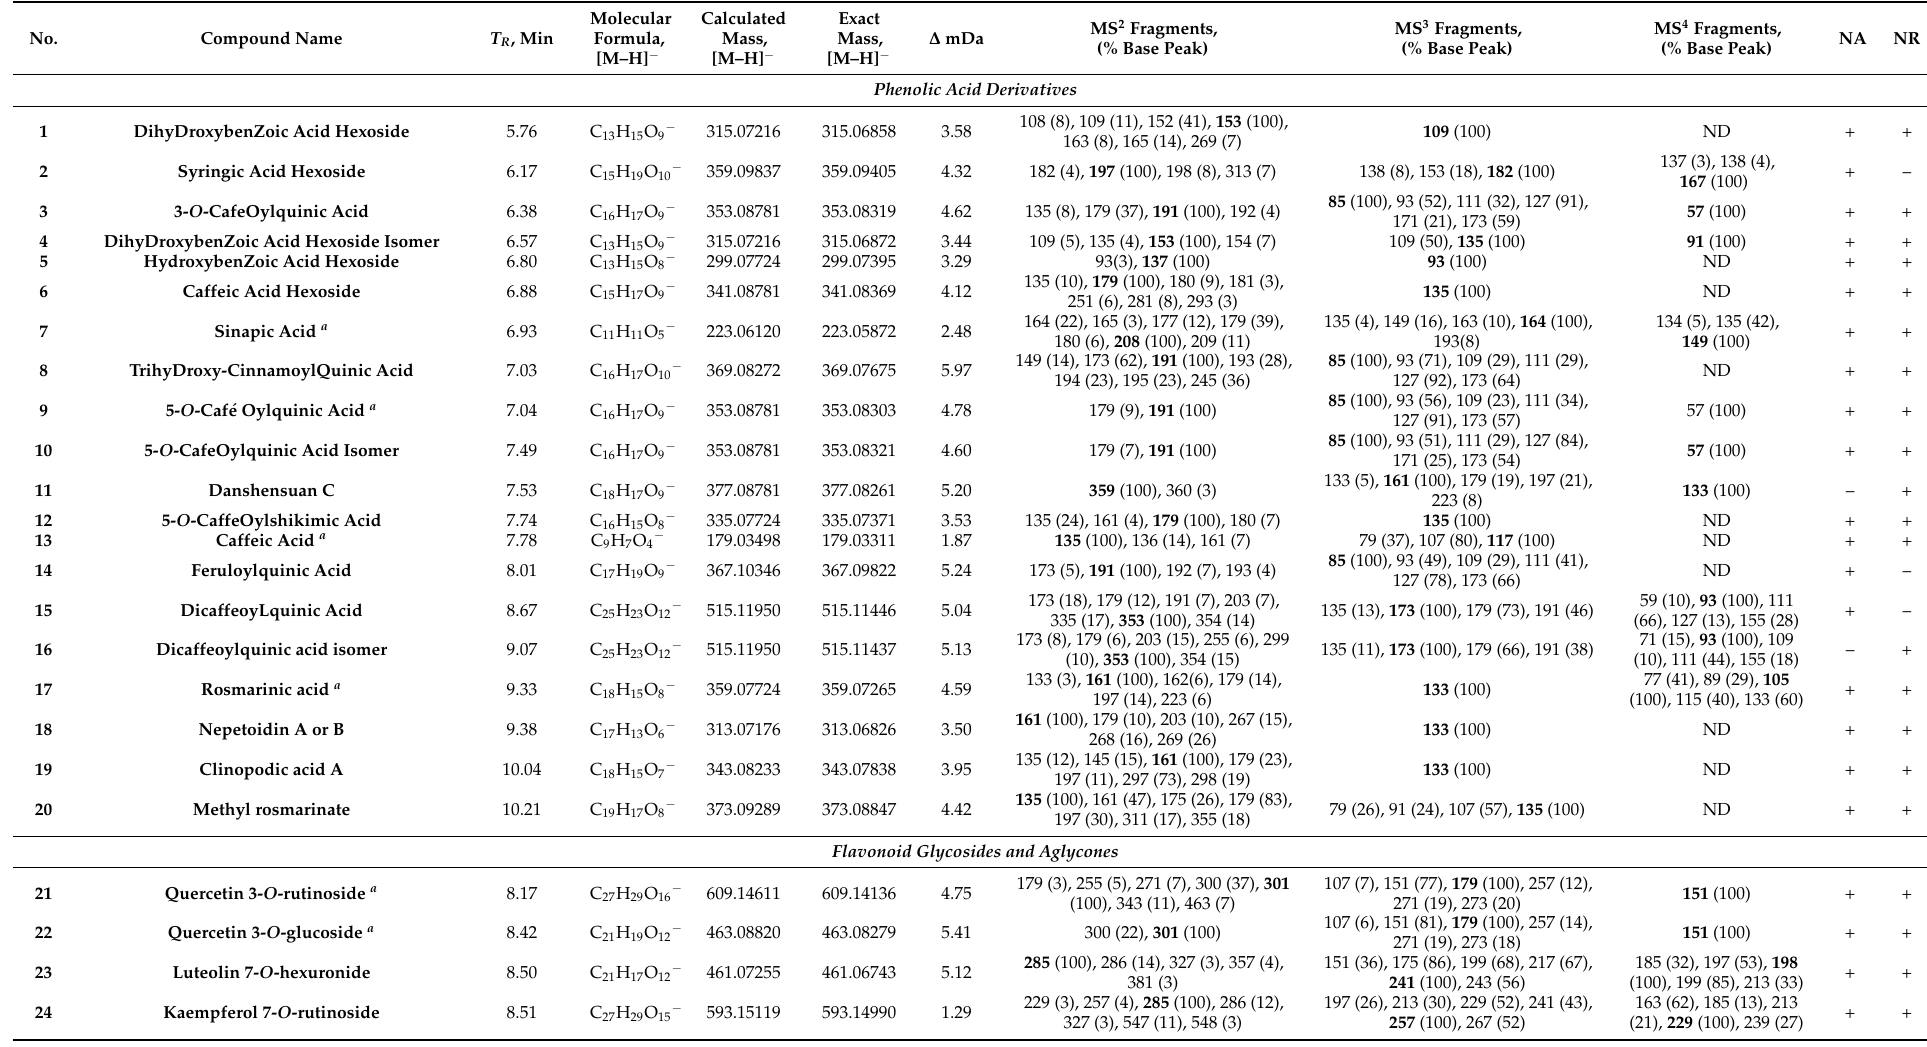
Table 1. Orbitrap-MS n analysis of phenolics and iridoid glucosides in methanol extracts of N. rtanjensis (NR) and N. argolica subsp. argolica